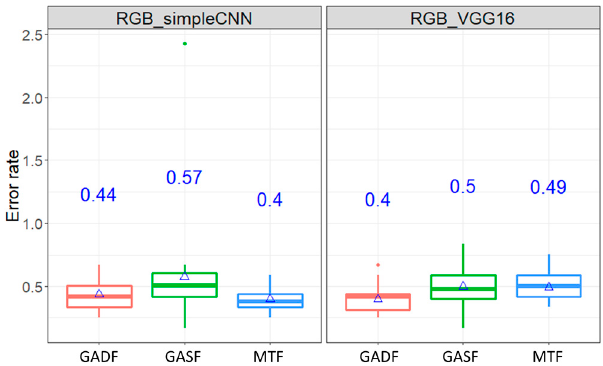
Figure 7. The boxplot of error rates of classifying RGB Wafer dataset images using simple ConvNet and VGG16.